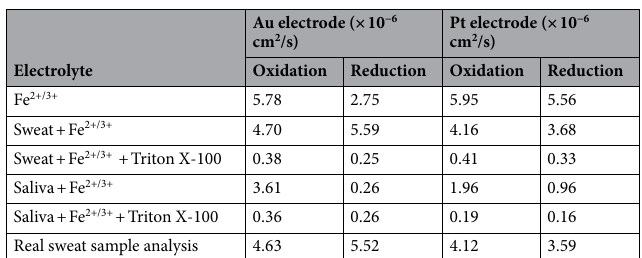
Table 2. Diffusion coefficient values of the redox probe obtained from the slope values of the plots shown in Fig. 5 for all the systems investigated in this work using Au and Pt electrodes.